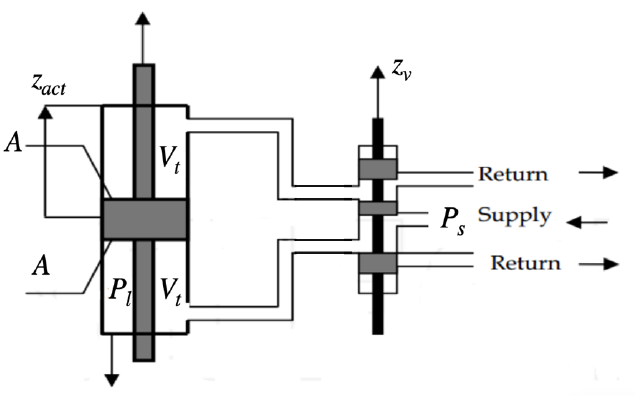
Figure 1. Half-Car Active Suspension System.